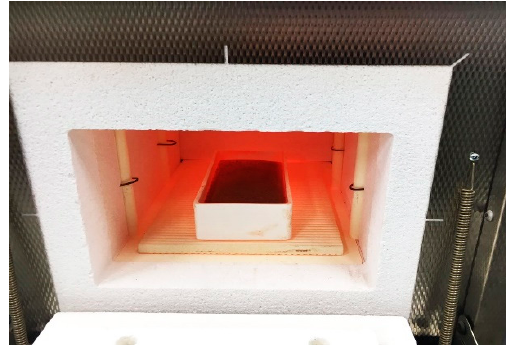
Figure 1. Calcination process of Hwangtoh powder.